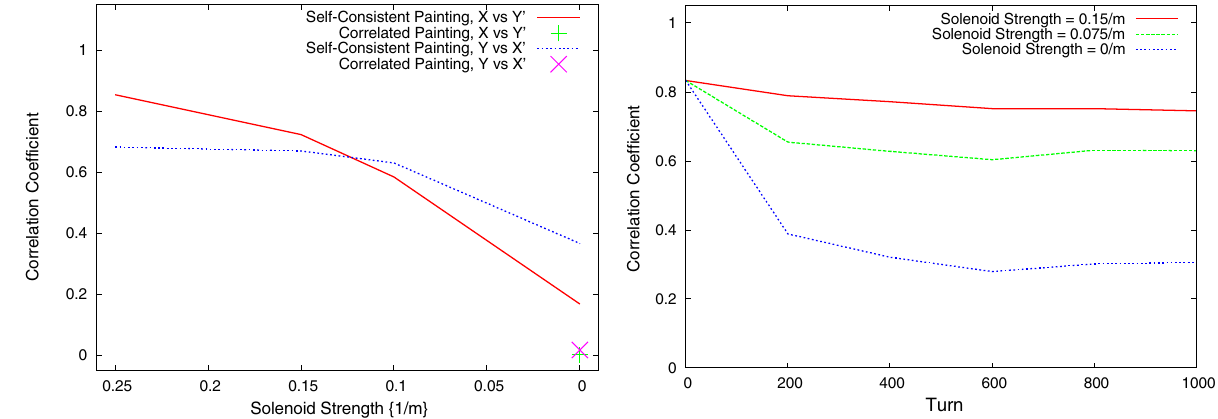
FIG. 7. (Left) Correlation coefficients following injection for x - y 0 and y - x 0 versus solenoid strength for self-consistent painting (red and blue curves) and for correlated painting (green and pink points). On the horizontal scale, a solenoid strength of 0.25 m corresponds to a magnetic field of 1.414 T at 1.0 GeV. (Right) Correlation coefficients in x - y 0 for different solenoid strengths as functions of the turn number during storage of a previously injected beam for an additional 1000